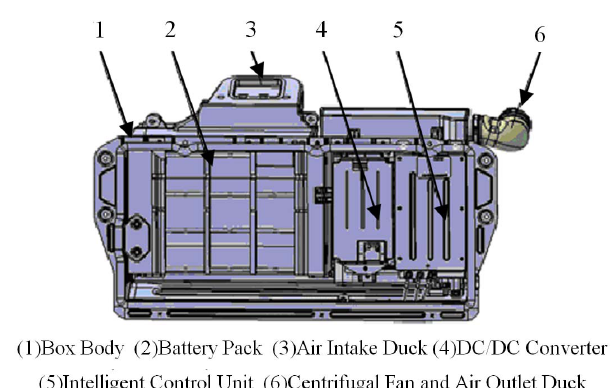
Figure 14. Configuration of the integrated pack and cooling system.